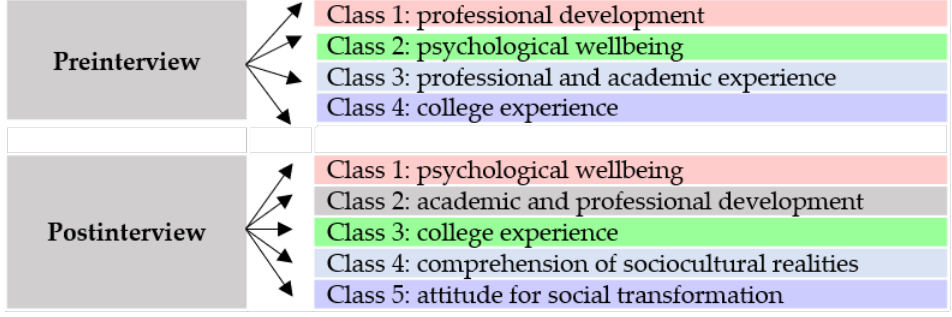
Figure 2. Distribution of the classes in pre and postinterviews.